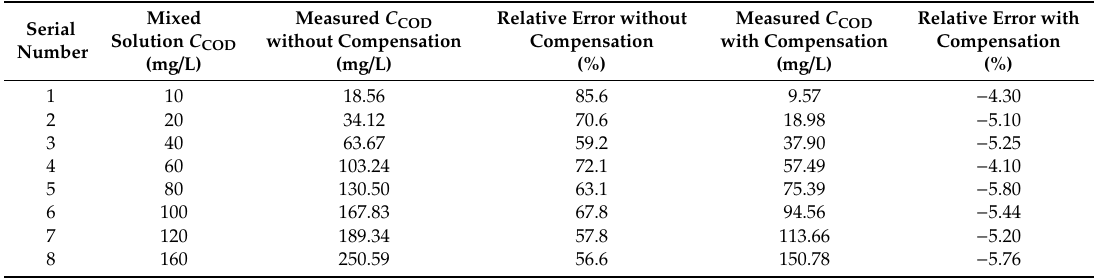
Table 1. Mixed solution COD concentration measured results and relative errors.